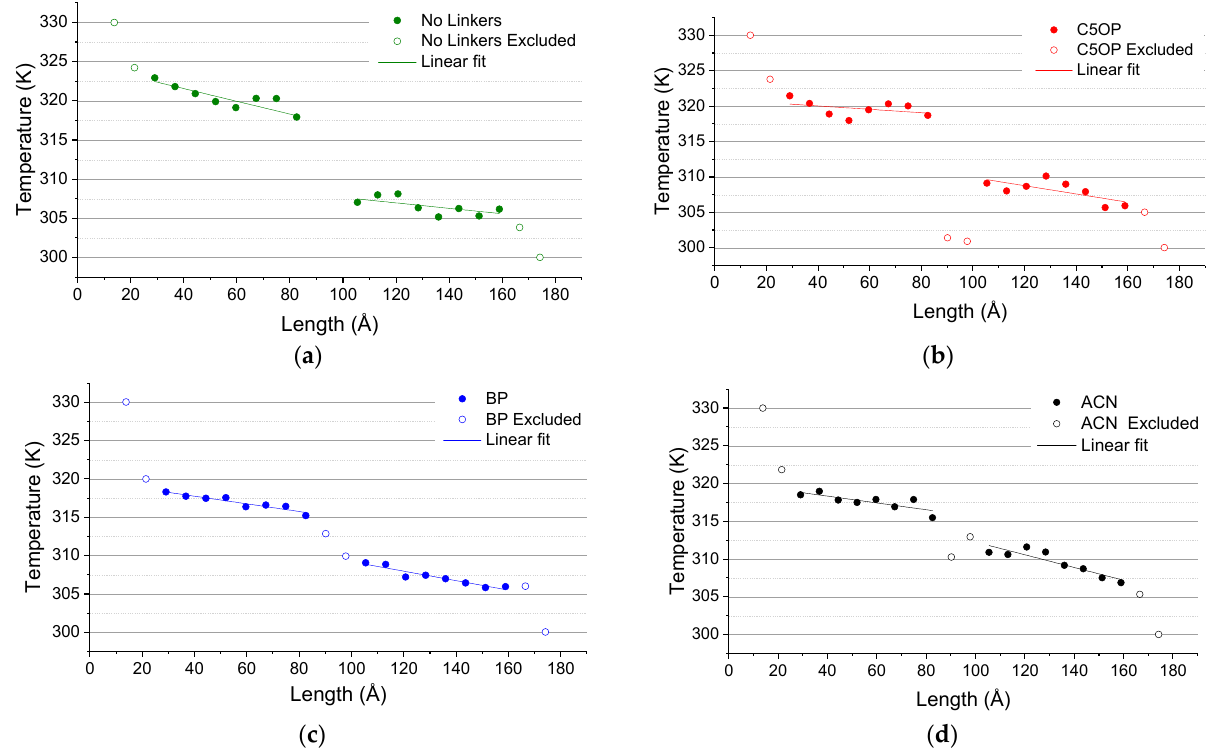
Figure 6. Temperature as a function of the slabs length without molecular junction ( a ), with C5OP ( b ), with biphenyl ( c ) anthracene ( d ) junctions, embedded in PDMS. Empty dots are values excluded from data fitting due to non ‐ linearities.